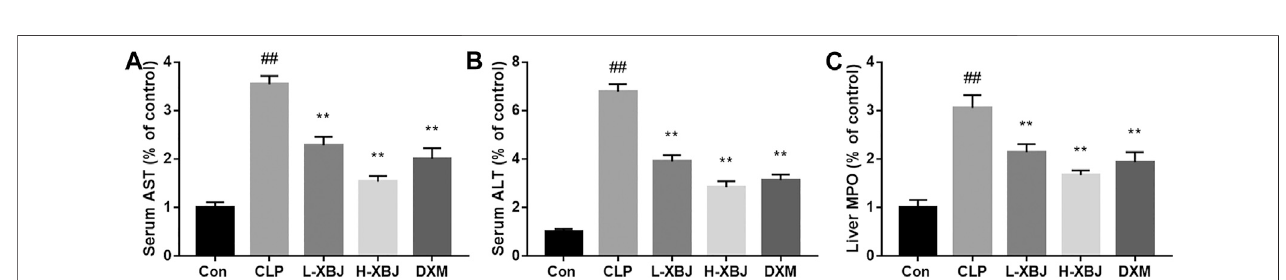
FIGURE2| XBJimprovesliverfunction (A) XBJreducedASTinserumofmicewithALIinducedbyCLP. (B) XBJreducedALTinserumofmicewithALIinducedby CLP (C) XBJ reduces MPO in the liver of mice with CLP-induced ALI. Con: control group that underwent sham surgery; CLP: model group with CLP surgery; L-XBJ: group with CLP surgery + XBJ low dose group (4 ml/kg/day); H-XBJ: group with CLP surgery + XBJ high dose group (8 ml/kg/day); DXM: group with CLP surgery + Dexamethasone (5 mg/kg/day). Compared with the control group, # p < 0.05, ## p < 0.01 were considered to be signi fi cant; Compared with the CLP group, * p < 0.05,** p < 0.01 were considered to be signi fi cant. Data are expressed as mean ± SD.